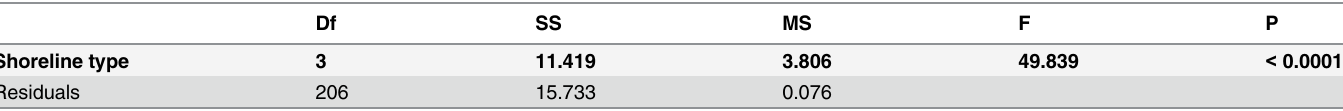
Table 1. Results of ANOVA on the Euclidean distance in ordination space between mean annual fish community structure and shoreline